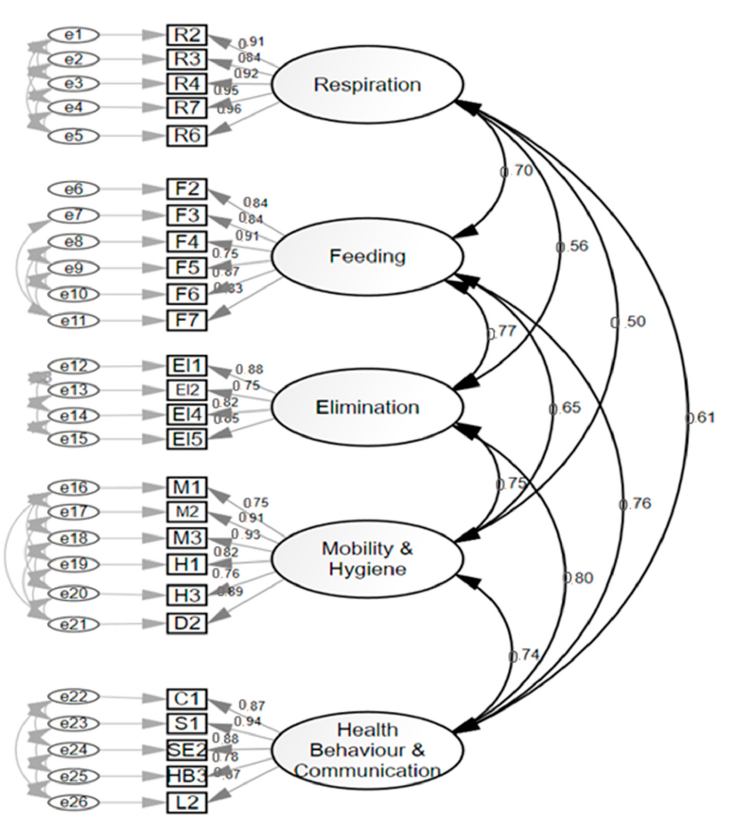
Figure 3. Confirmatory factor analysis 26-item scale (short-form version).